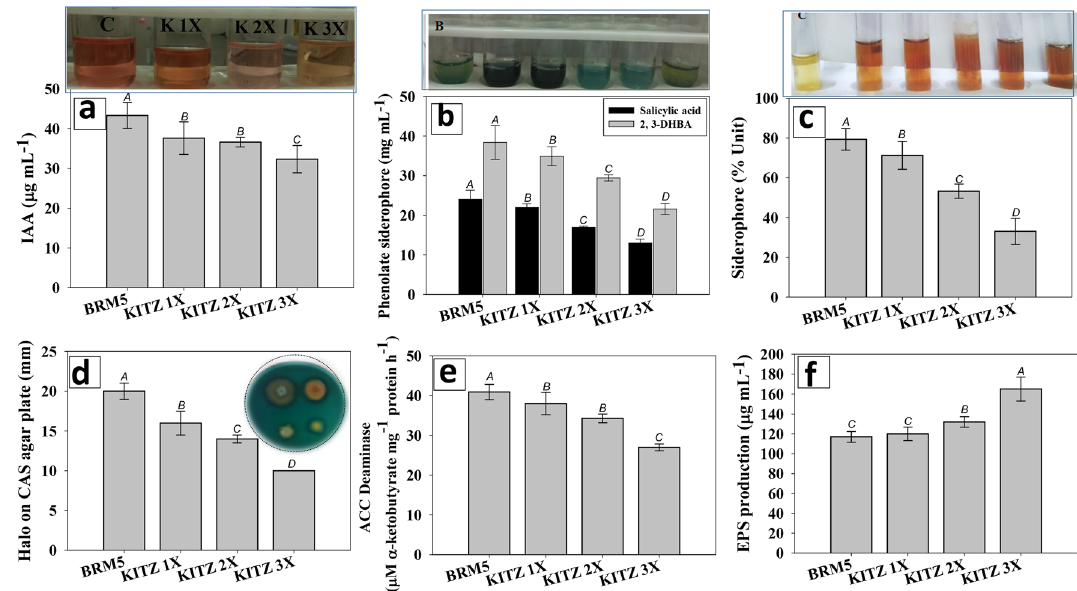
Figure 3. Plant growth regulating bioactive molecules; indole-3-acetic acid ( a ), phenolate type siderophore [salicylic acid and 2.3-DHBA) ( b ), siderophore % unit ( c ), chrome azurol-S agar ( d ), ACC deaminase ( e ) and exopolysaccharide ( f ) produced by M. ciceri BRM5 in the absence and presence of different doses of KITZ. In this figure, bar diagrams represents the mean values (mean ± S.D) of three independent replicate whereas, error bars depicts the standard deviation (S.D). Different letters on bars denotes that mean values are significantly different (at p ≤ 0.05) according to